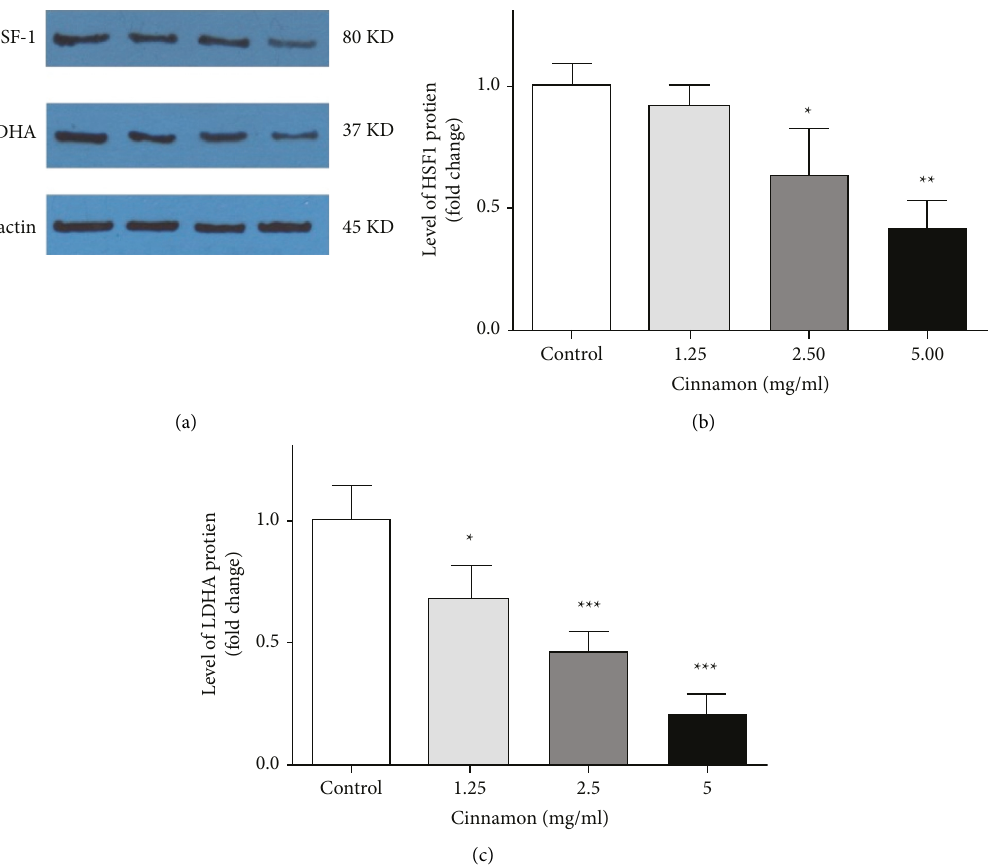
Figure 4: Effect of different concentrations of Cinnamon aqueous extract on 5637cell. (a) The image of protein extraction by the im- munoblotting result, (b) HSF1, and (c) LDHA protein expression. Data are reported as the mean ± SD and each value is the average of at least three independent replicates. ( ∗ P < 0 . 05, ∗∗ P < 0 . 01 and ∗∗∗ P < 0 . 001 compared to the control group). HSF1: heat-shock transcription factor1, LDHA: lactate dehydrogenase A.